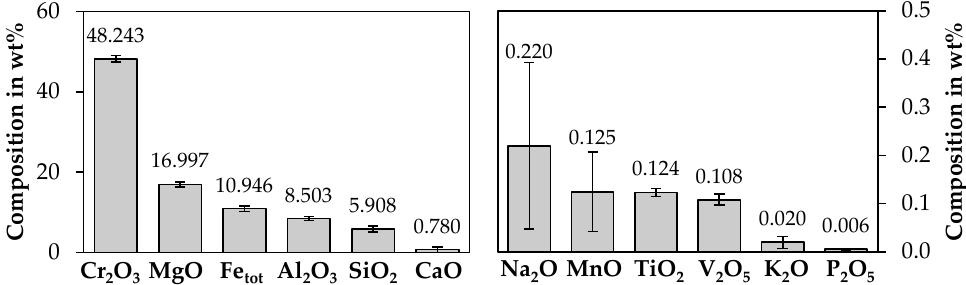
Figure 1. Bulk chemical analysis of chromite concentrate.